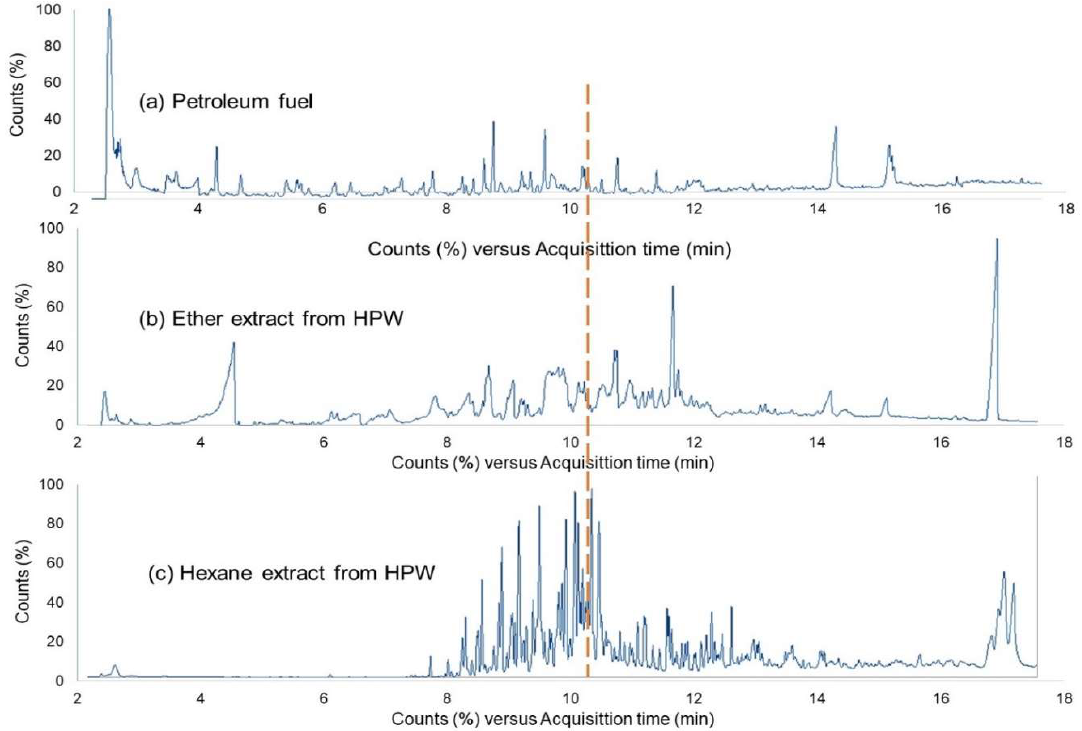
Figure 7. GC-MS TICs of ( a ) petroleum fuel, ( b ) ether extract, and ( c ) hexane extract.